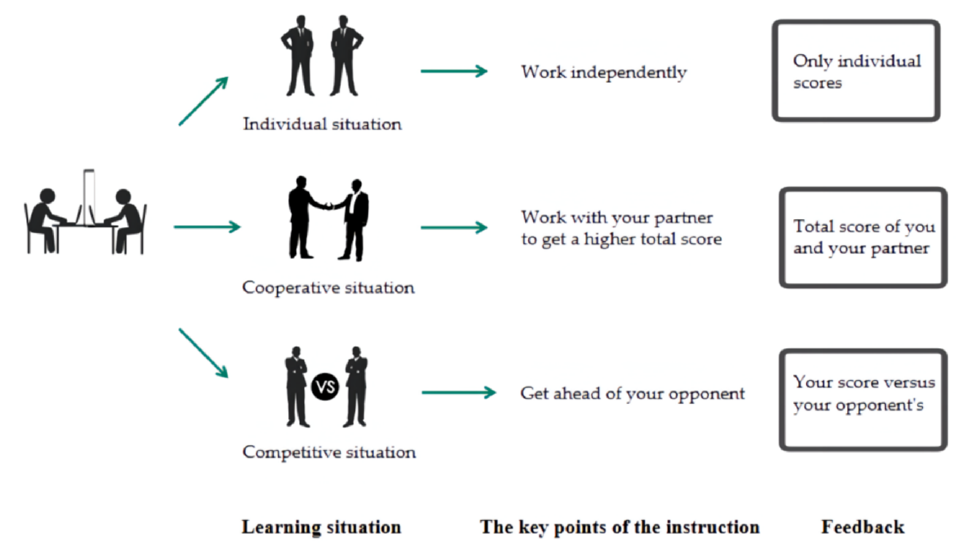
Figure 2. The description of the experimental procedure.